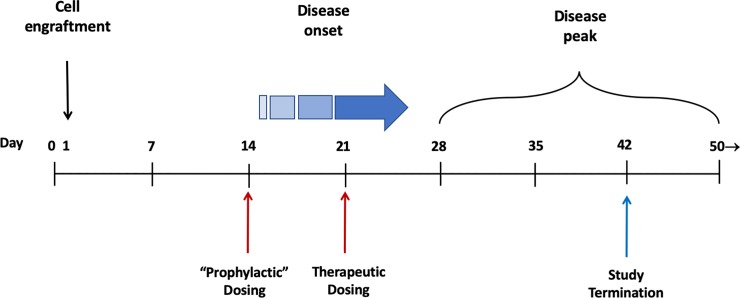
Schematic outlining T-cell colitis disease progression time course.